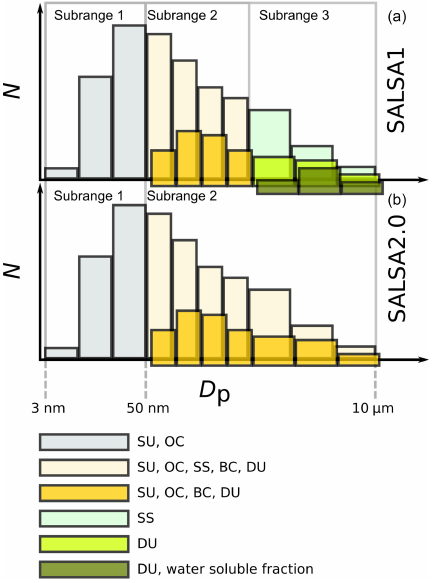
Figure 1. Schematic of the number ( N ) size distribution represen- tation as a function of diameter D p in SALSA1 (a) and SALSA2.0 (b) . The color of each size class indicates which compounds are included in the size